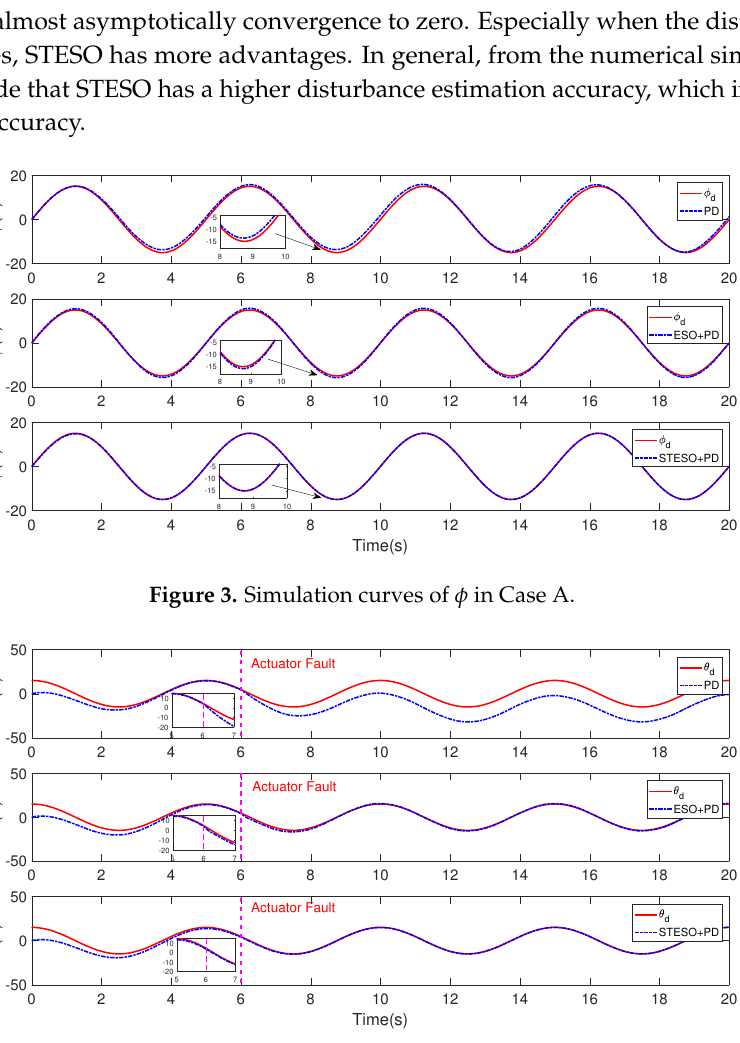
Figure 4. Simulation curves of θ in Case A.